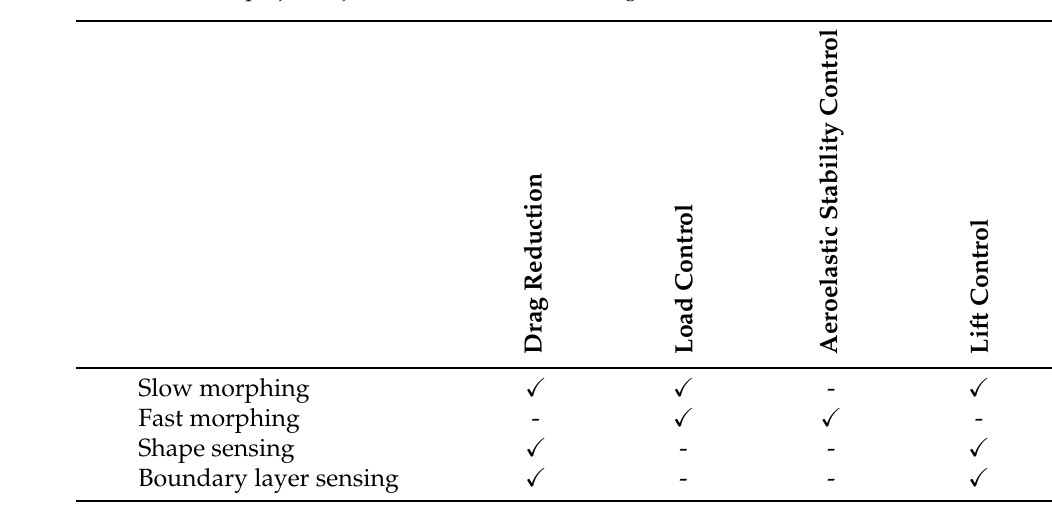
Table 1. SmartX project objectives and related